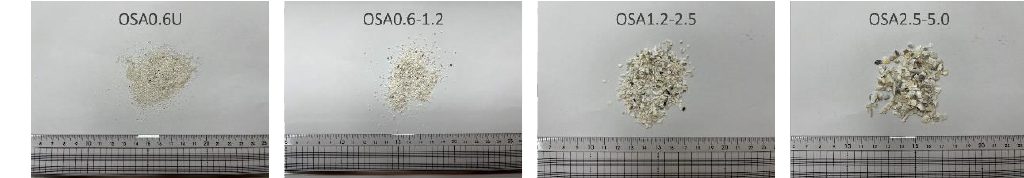
Figure 3. The oyster shell aggregate which was classified according to the particle.